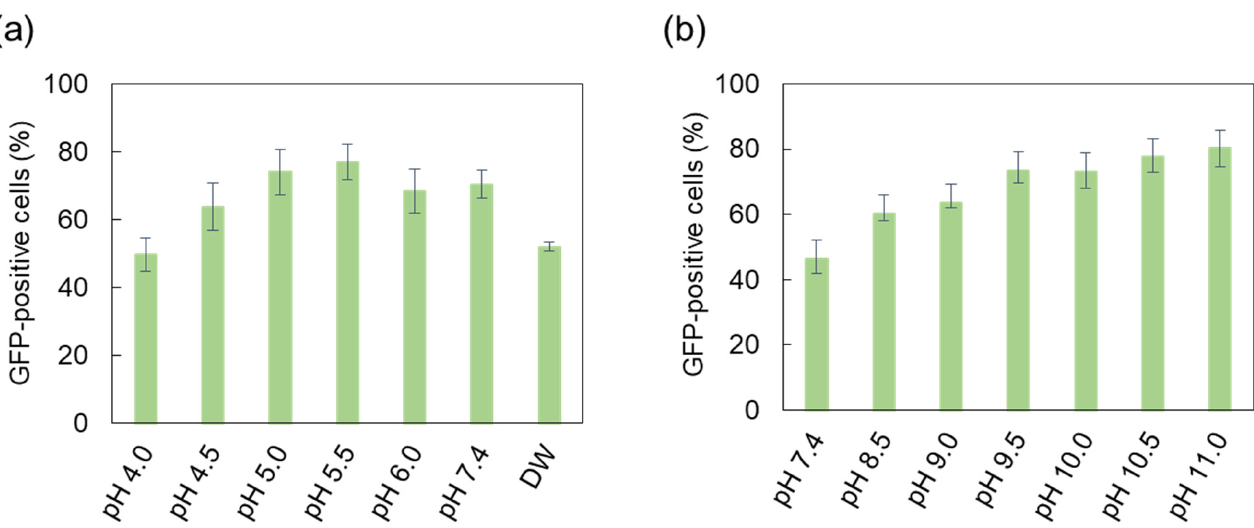
Figure 2. Changes in the transfection efficiency depending on pH of the complexation solution: ( a ) effects of acidic pH of the liposome formation solution; ( b ) effects of alkaline pH of the pDNA solution. GFP-positive cells were analyzed at 24 h after transfection. The results represent the mean ± standard deviation ( n = 3). GFP, green fluorescent protein; pDNA, plasmid DNA.